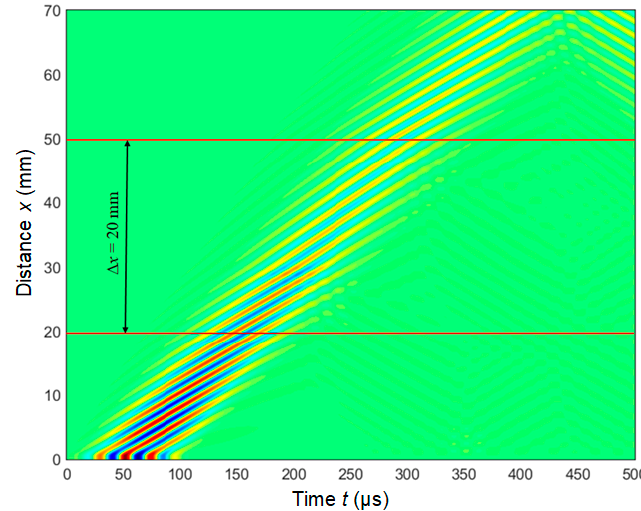
Figure 6. Simulated B-scan of the mcia MICA paper with hypothetic two rectangular zones with different elastic properties and thickness. The horizontal dashed red lines indicate borders of the rectangular darker zone.